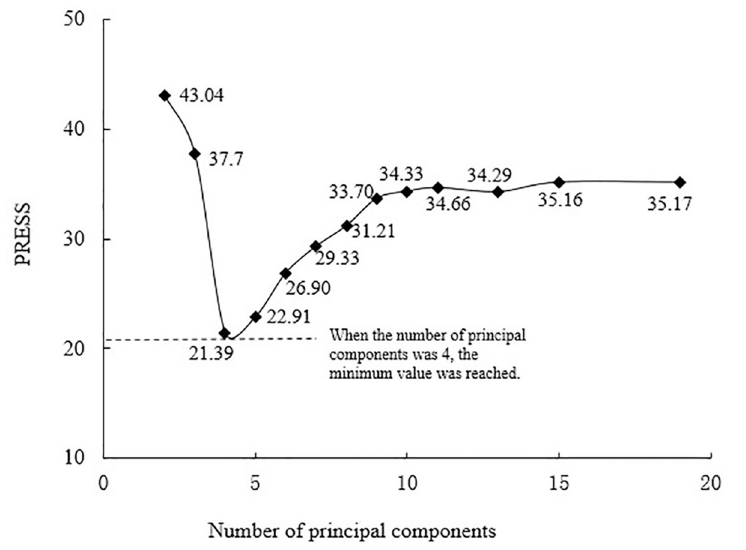
Fig 1. PRESS changes with the principal components.